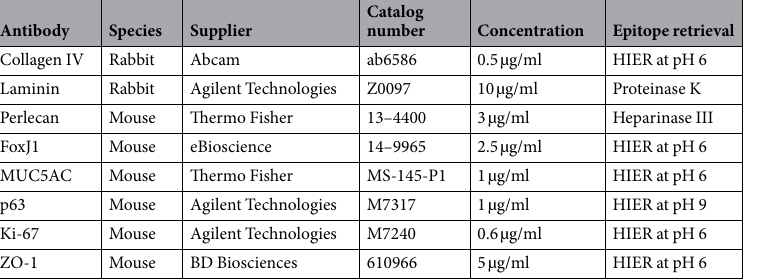
Table 1. Primary antibodies and epitope retrieval methods used for immunohistochemistry. HIER = Heat induced epitope